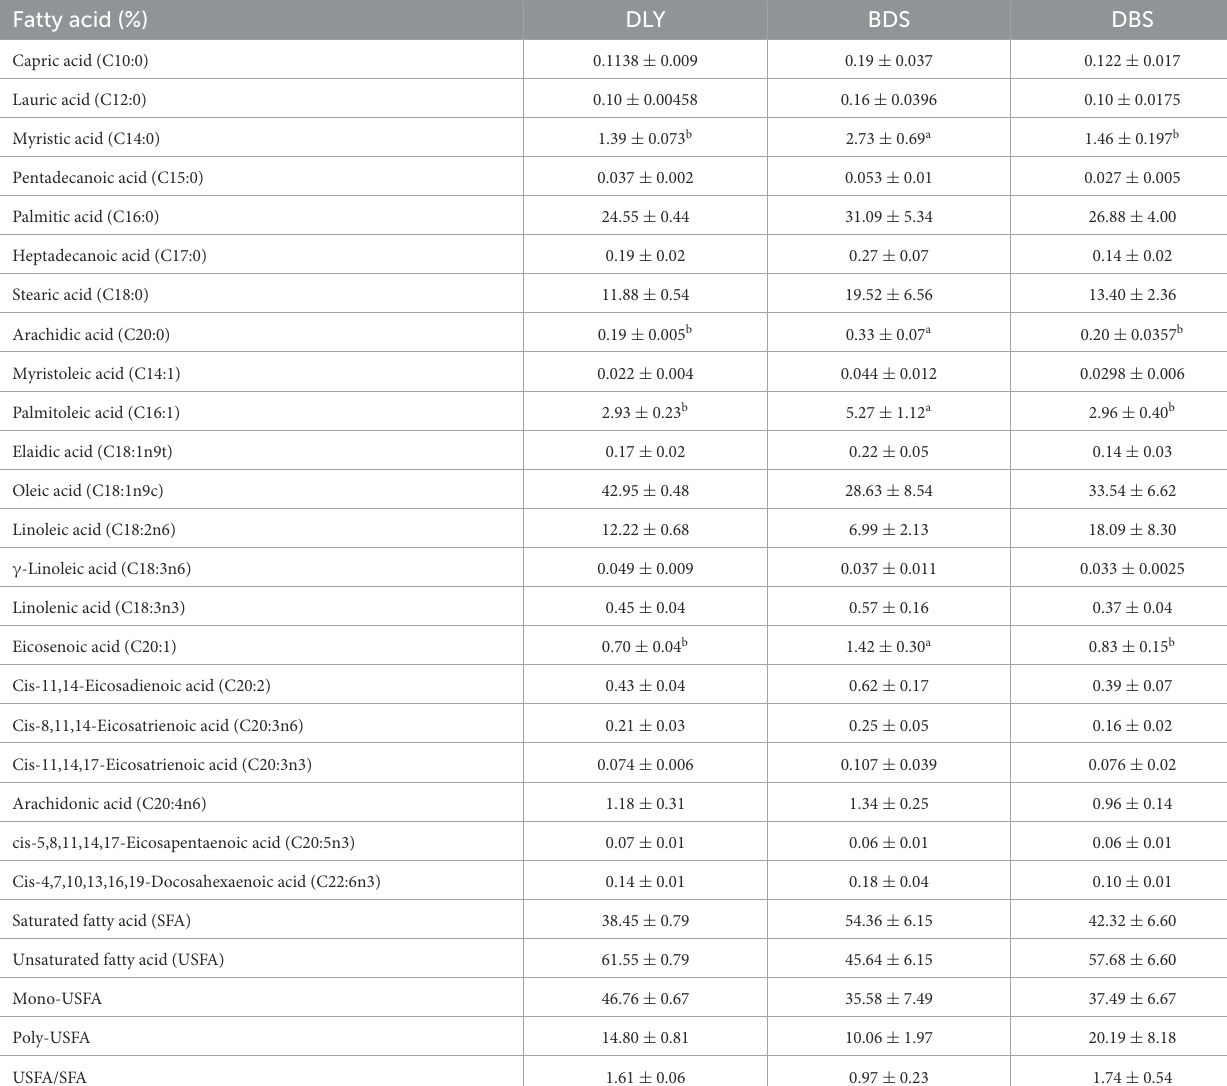
TABLE 3 Relative percentages of fatty acids in longissimus dorsi muscle from DLY, BDS and DBS. Fatty acid